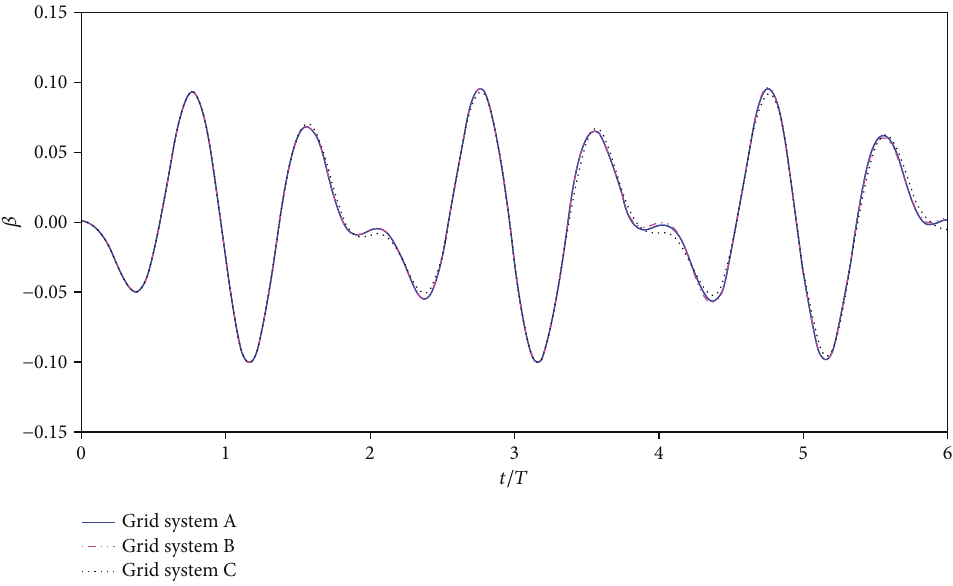
Figure 4: The time variation of passive pitching angle β under three di ff erent grid systems.